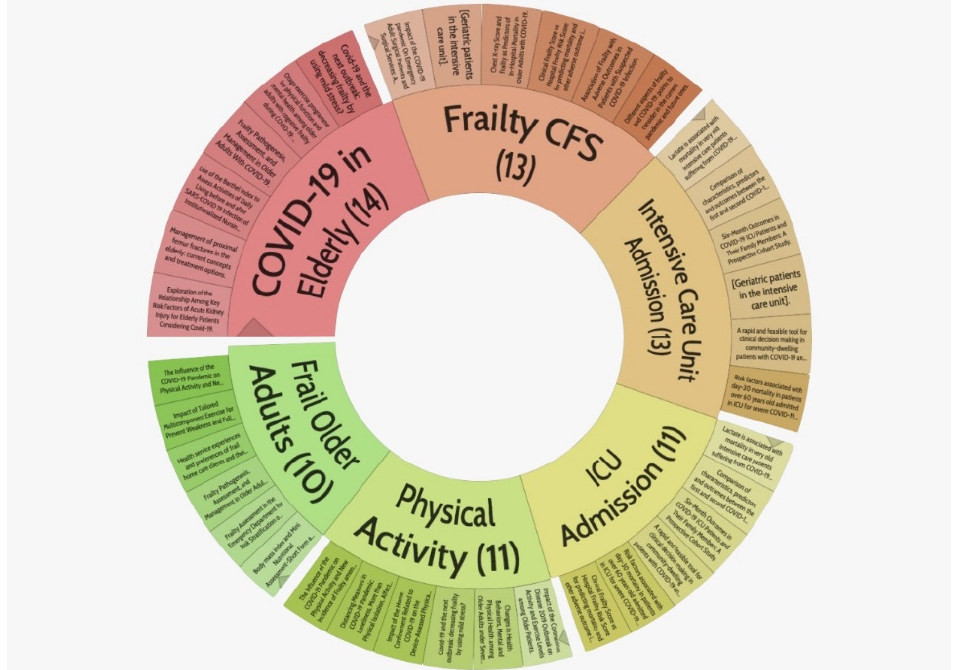
Figure 1. Stratified search clustering COVID-19 infections in geriatric elderly patients and its rela- tionship with frailty and its severity evaluated by the Clinical Frailty Scale. The figure was created using Carrot2 software by clustering algorithm Lingo and data obtained from the PubMed database using the search pattern “Frailty” AND “COVID-19” and all retrieved results. Available in https://search.carrot2.org/#/search/pubmed/frailty%20and%20COVID-19/pie-chart (Accessed on August 22 2021).